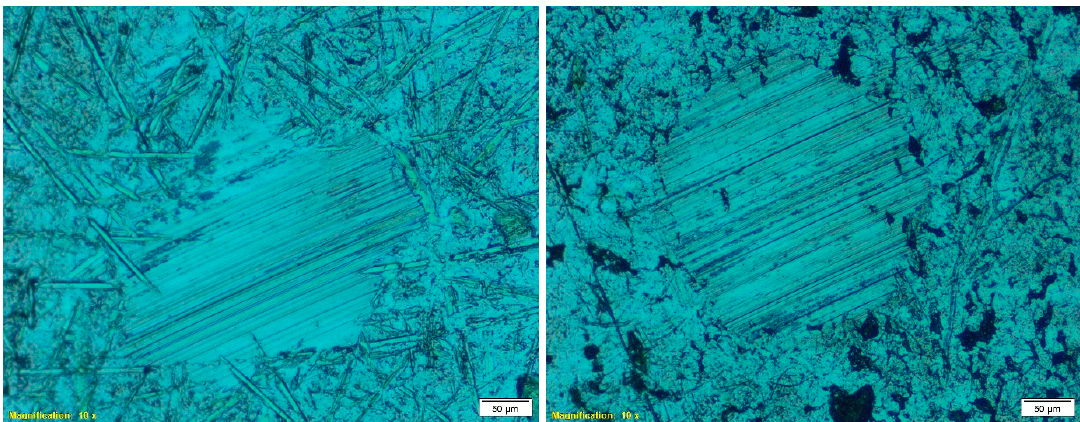
Figure 6. Selected pictures of wear marks produced during the tribological tests when using polyurethane oleogels prepared with barley- (CPB147-15) ( left ) or wheat- (CPW301.45-10) ( right ) straw-derived cellulose pulps as lubricants.